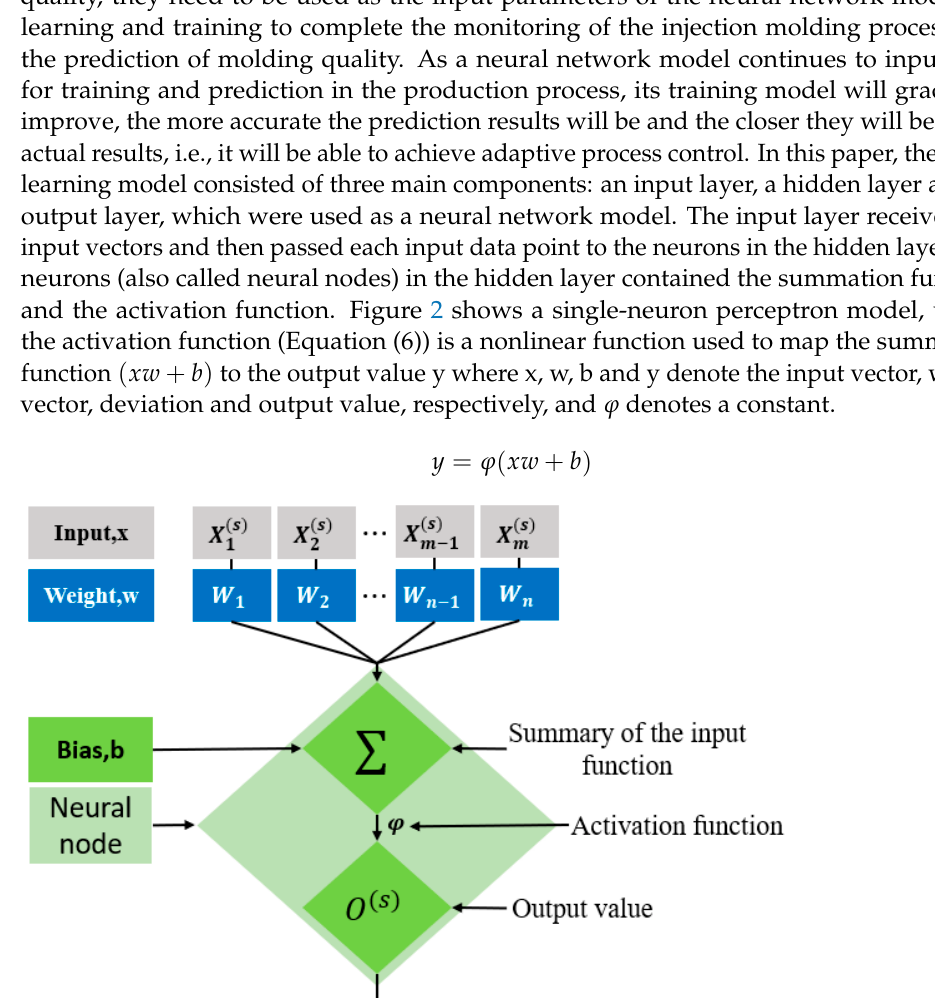
Figure 3. Structure of the ANN (Artificial Neural Network) model. Figure 4 shows the neural network architecture of the first layer in the hidden layer. Equation (7) represents the expressions of the output vector 𝑂 (cid:2869)((cid:3046)) of the first layer in the hidden and output layers, and the expressions of the other layers are the same as above.